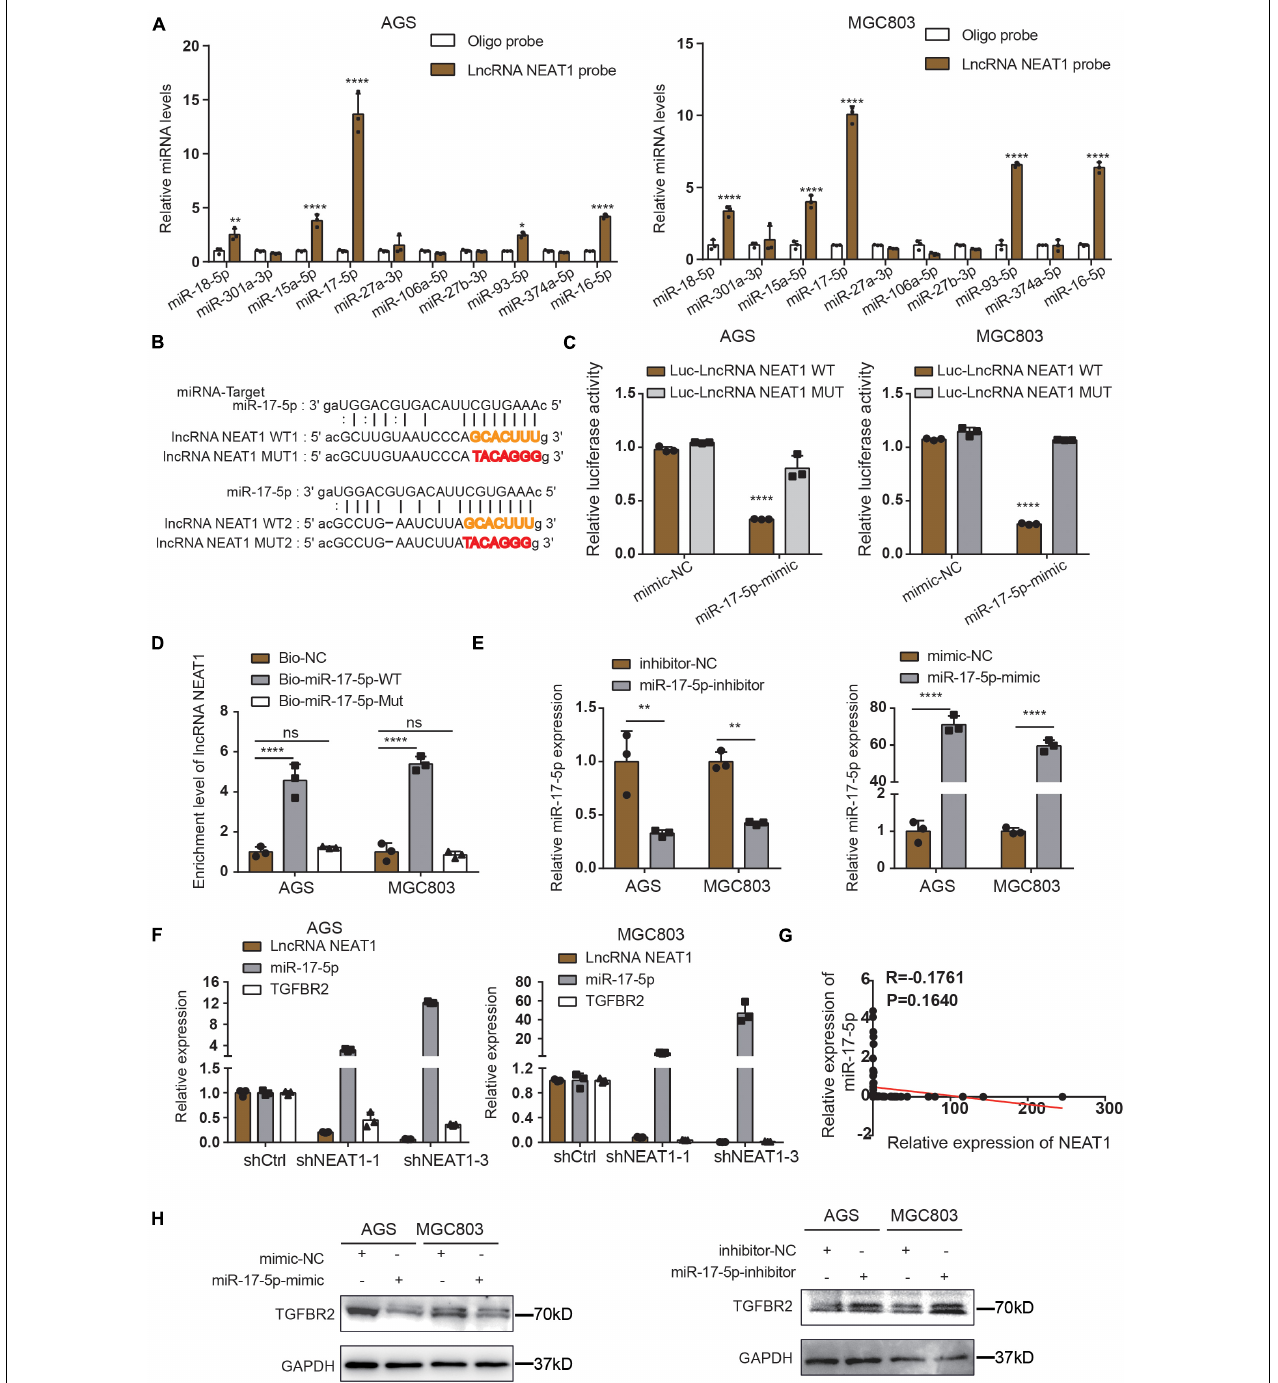
FIGURE 3 | NEAT1 regulates TGFBR2 expression by directly targeting miR-17-5p. (A) The expression levels of 10 candidate miRNAs were detected by RT-qPCR after RNA pulldown assay. (B) Predicted binding sites of miR-17-5p on LncRNA NEAT1 are shown. (C) Luciferase activity was conducted in AGS and MGC803 cells co-transfected with luciferase reporter containing LncRNA NEAT1 sequences with wild type and mutant binding site of miR-17-5p and the mimic of miR-17-5p or control. (D) Biotin-coupled miR-17-5p wild type (Bio-miR-17-5p-WT) or its mutant (Bio-miR-17-5p-Mut) captured relative expressions of LncRNA NEAT1 in the complex. Relative level of LncRNA NEAT1 was normalized to input. (E) Transfection efficiency of miR-17-5p inhibitor (left panel) and mimics (right panel) in AGS and MGC803 cells were validated by RT-qPCR assay. (F) Relative mRNA levels of miR-17-5p and TGF β R2 detected by RT-qPCR after knockdown NEAT1 in AGS and MGC803 cells. (G) Regression analysis of GC tissue showed a negative correlation between miR-17-5p and NEAT1 ( n = 64). (H) Effects of miR-17-5p inhibitor (above panel) and mimics (below panel) on TGF β R2 expression in AGS and MGC803 cells were validated by western blot. * P < 0.05, ** P < 0.01, **** P < 0.0001.